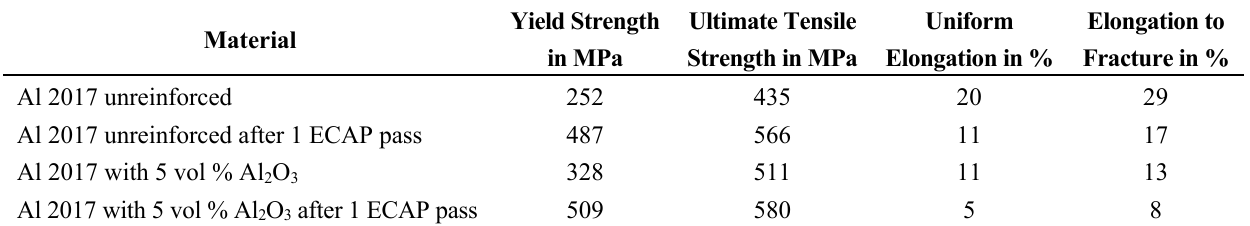
Table 2. Tensile properties of the unreinforced and reinforced conditions. Material